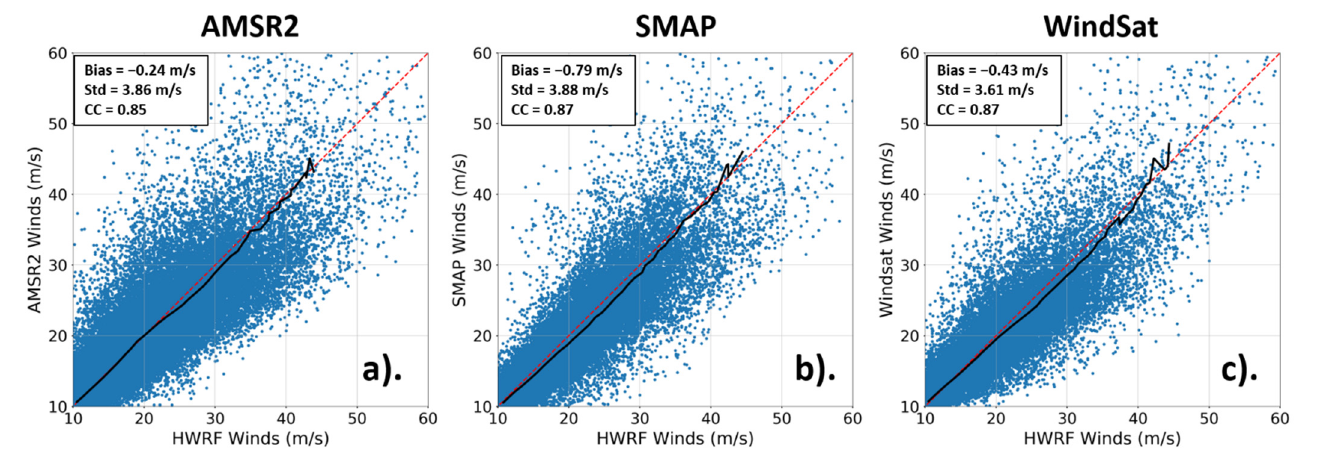
Figure 12. Scatterplots of AMSR-2 ( a ), SMAP ( b ), and WindSat ( c ) winds plotted against HWRF winds that have been temporally interpolated to the time of satellite overpasses for all 19 storms between 2017 and 2020 analyzed in this study. The bias, standard deviation, and correlation coefficient for all wind speed matchups >10 m/s and <60 m/s are given in the top left corner for each plot. The black line represents the average of the binned HWRF vs. satellite winds and the binned satellite vs. HWRF winds. The red dashed line represents the one-to-one line (i.e., no bias). Note that no HWRF data used in this comparison were shifted before interpolation due to the fact that the statistical sample was large.